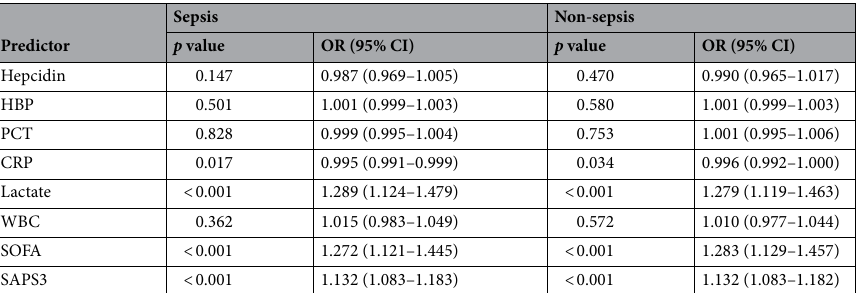
Table 8. Results from logistic regressions where 28-day mortality is set as the dependent variable, predicted by arrival values of biomarkers, SOFA or SAPS 3. An interaction model was used to account for different effects in the Sepsis/Non-Sepsis group. Odds ratio (OR) presented with 95% confidence interval. CRP C-reactive protein, HBP heparin-binding protein, PCT procalcitonin, WBC white blood cells, SOFA Sequential Organ Failure Assessment, SAPS3 Simplified acute physiology score III.